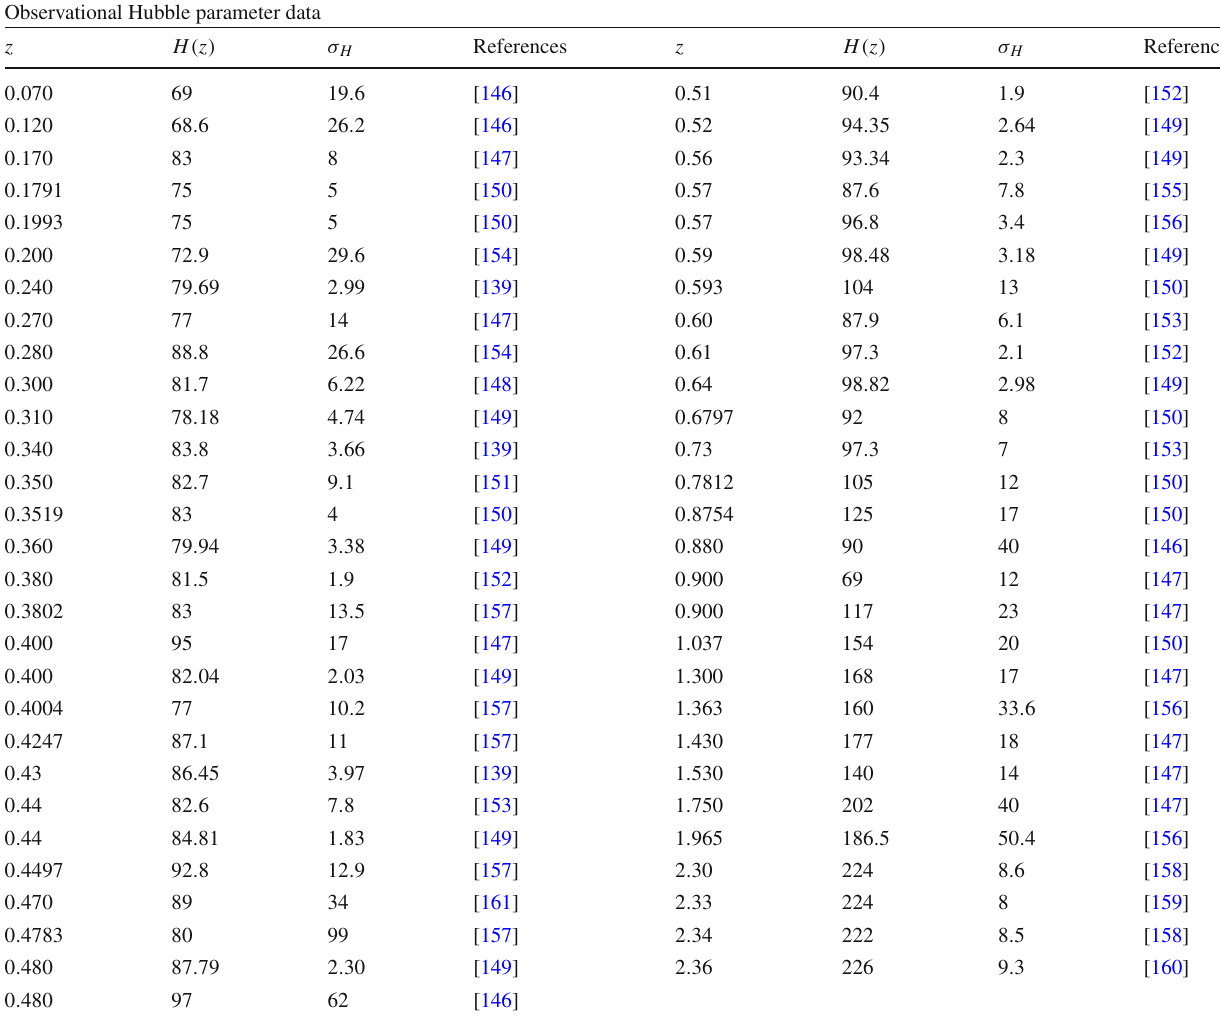
Table 1 The 57 data points of the Hubble parameter considered in the present paper Observational Hubble parameter